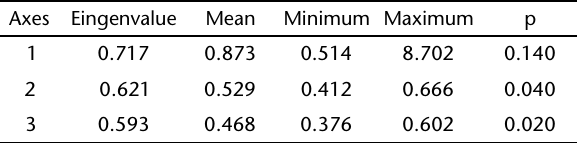
Table IV. Species correlation with the matrix of environmental variables in the Canonical Correspondence Analysis with the significance level obtained through the Monte Carlo test. (spp- envt Corr) Species correlation with environmental